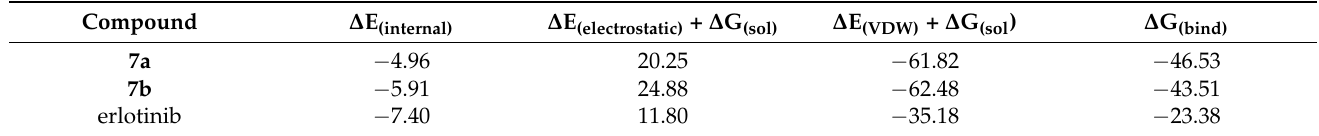
Table 10. Calculated binding free energies of tested compounds.